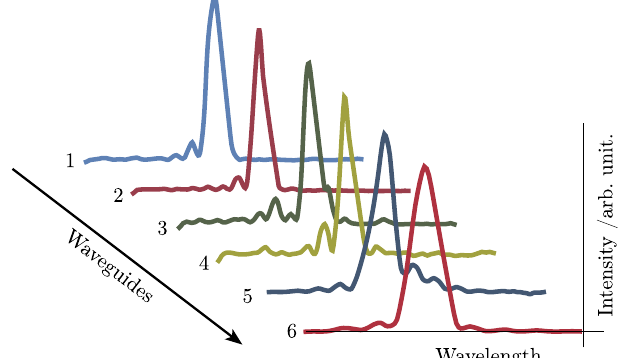
FIG. 14. Phase-matching profiles of different waveguides in the same chip. We observe a variability of the shape of the phase- matching profiles, which can be caused by periodic poling